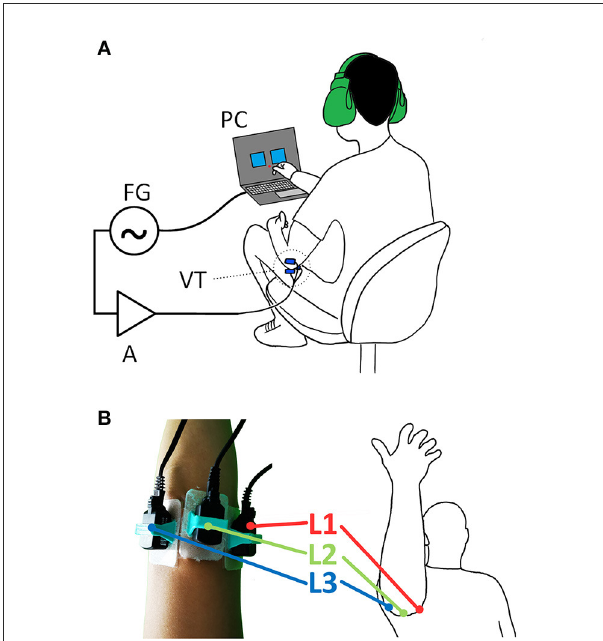
FIGURE1 The experimental setup: (A) three vibrotactile transducers (VT) are controlled via a personal computer (PC) connected via USB to a frequency generator (FG) and an amplifier (A); (B) the transducers are fixed onto the bony landmarks (figure shows right arm) of the dominant hand: (L1) epicondylis medialis, (L2) ulnar olecranon and (L3) epicondylus lateralis in 3D printed holder and medical grade double sided sticker and mounted.